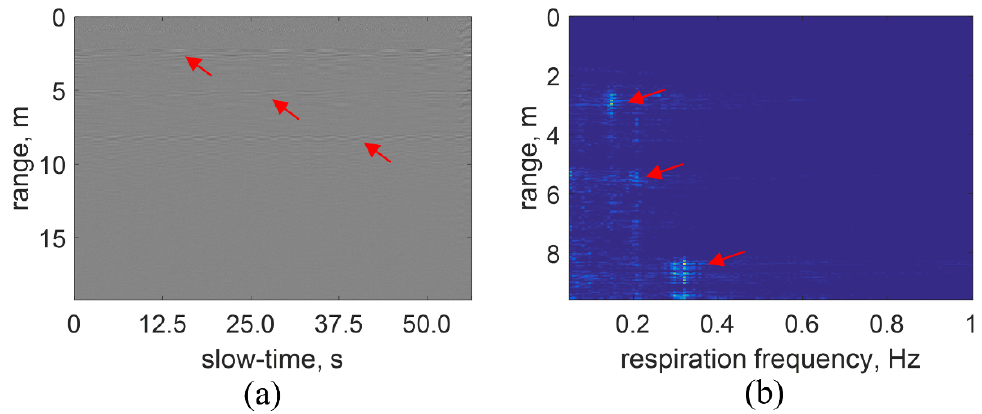
Figure 7. Experimental results for stationary operating mode. ( a ) The preprocessing slow-time range matrix. ( b ) The resultant frequency range matrix.